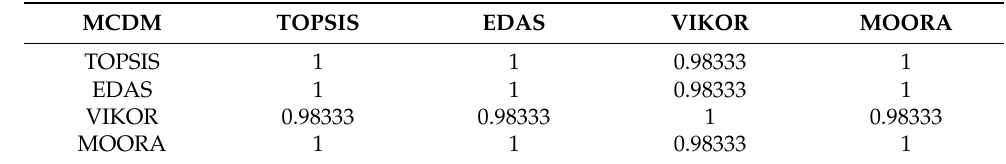
Table 6. Spearman’s rank correlation coefficients for case study 2. MCDM TOPSIS